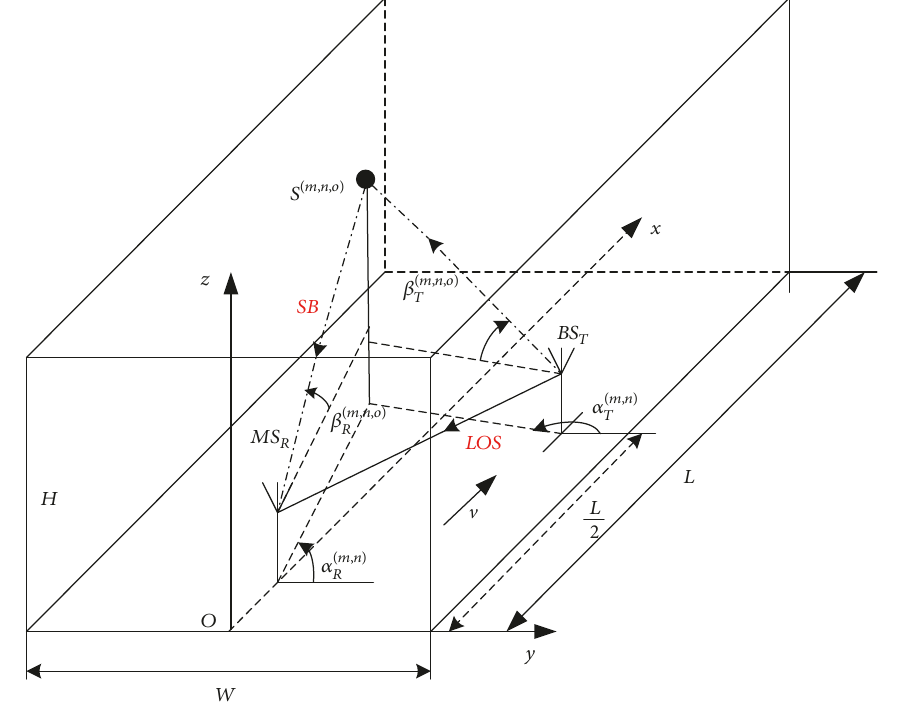
Figure 1: Propagation environment inside tunnels. Table 1: Definition of parameters.